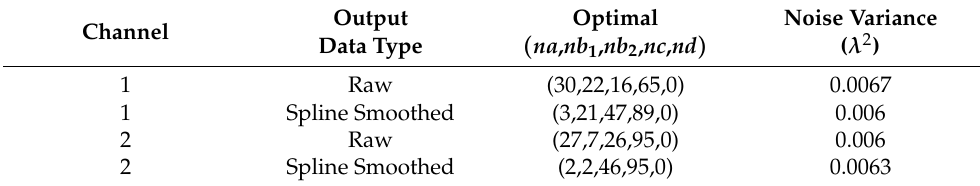
Table 1. Structural indices of optimal MISO BJ models and estimated noise variances. Channel